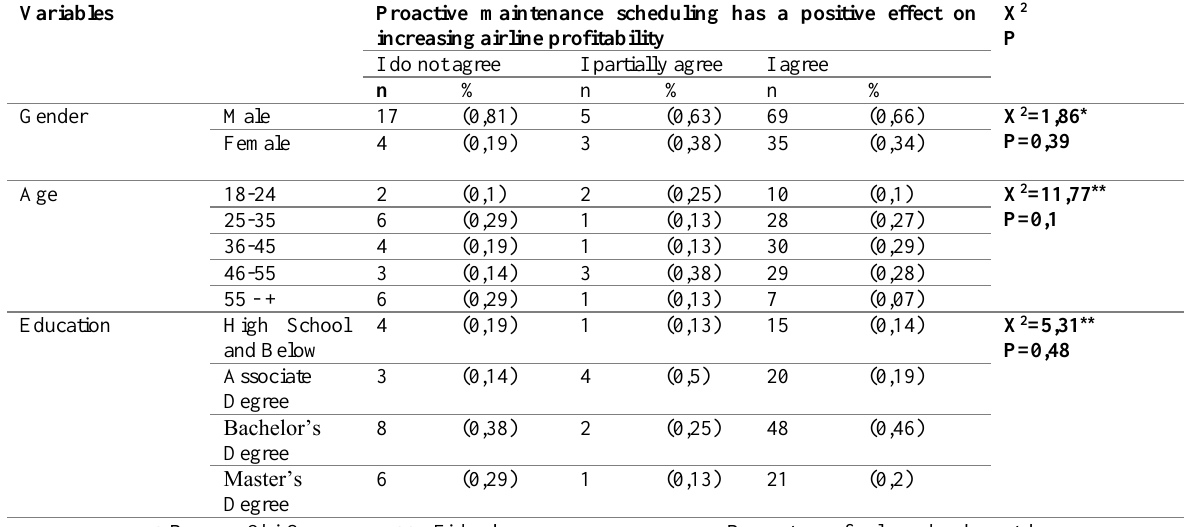
* Pearson Chi-Square ** Fisher's Percentage of column has been